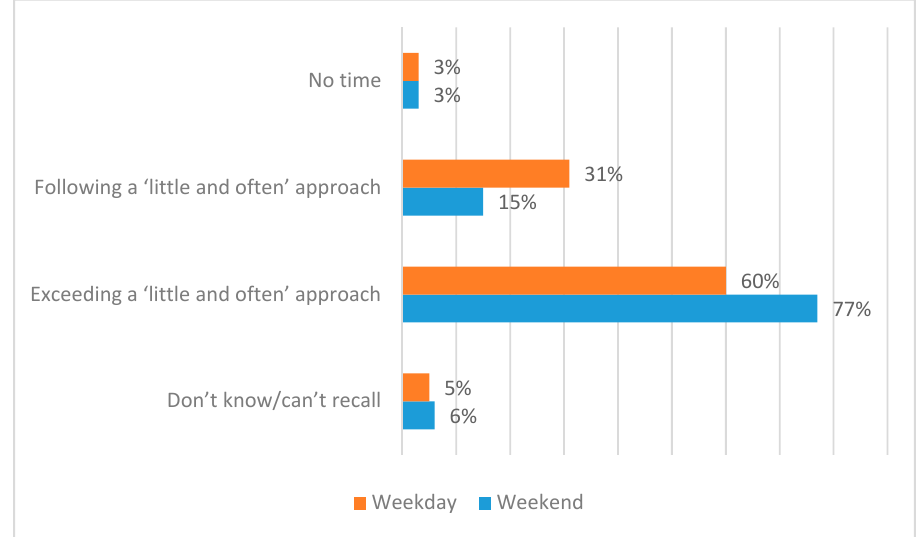
Figure 4. Daily sunlight exposure behaviours.